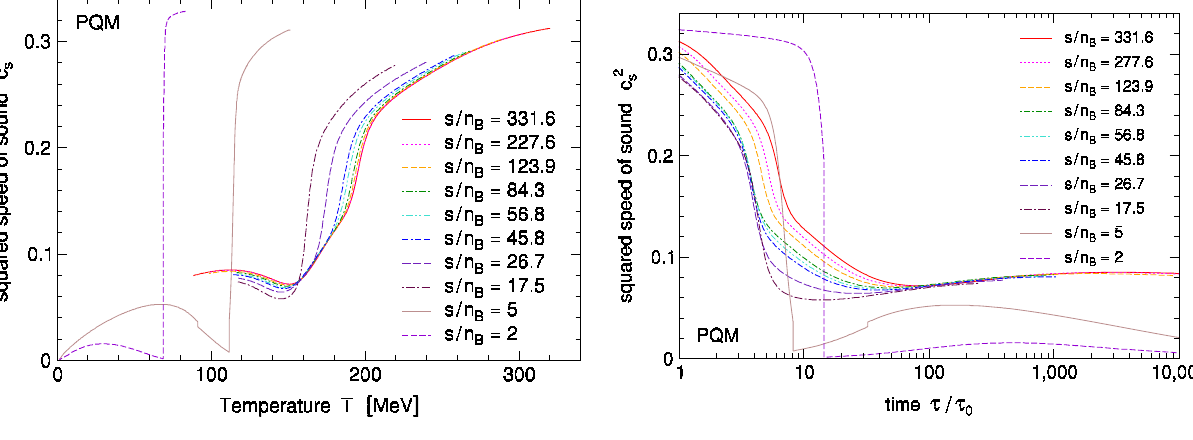
Fig. 7 The same as in Fig. 6, but for the PQM